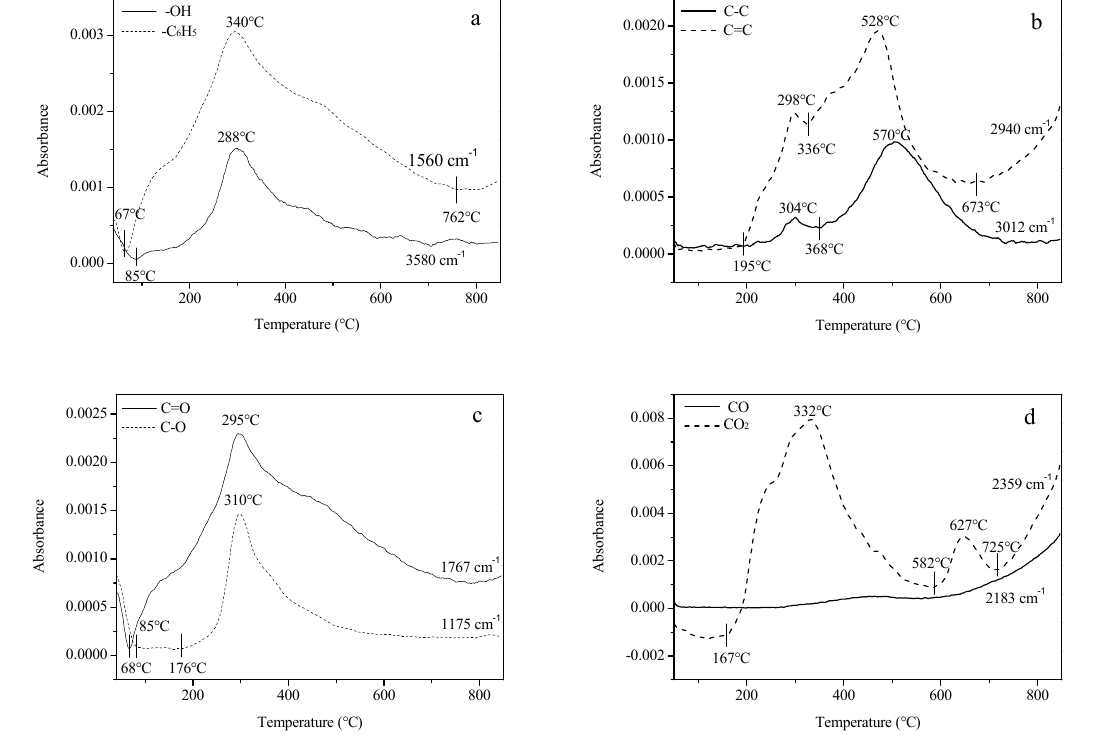
Figure 5. FTIR spectrum for pyrolysis products evolving from the sludge at different temperatures. (a) -OH, -C 6 H 5 ; (b) C-C, C=C ; (c) C-O, C=O ; (d) CO, CO 2 .